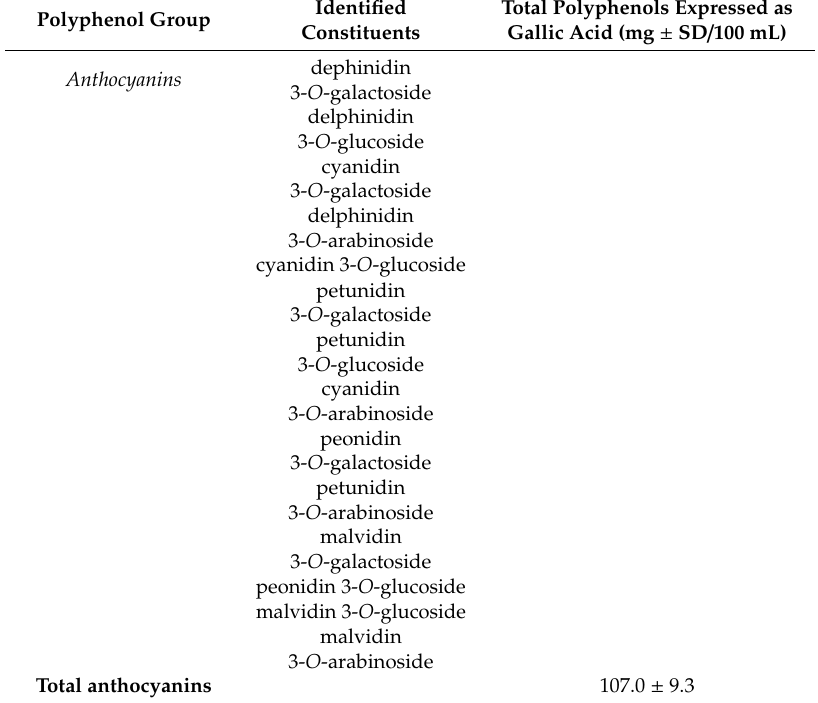
Table 1. Identified polyphenols and total content of each class of constituents in blueberry